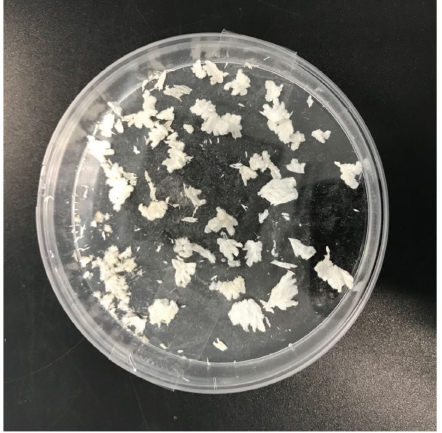
Figure 2. Oleanolic acid in the form of prismatic